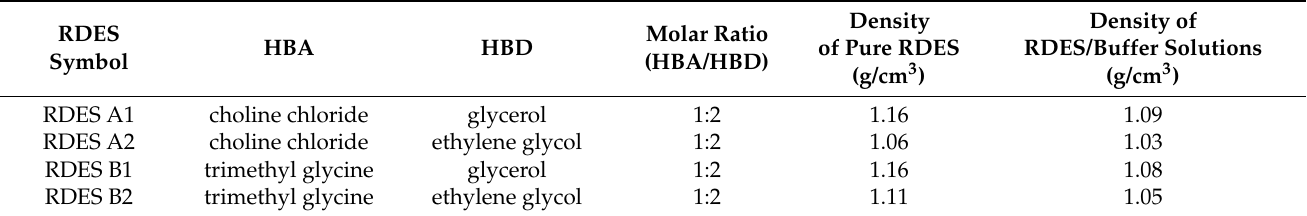
Table 2. List, composition, and density of RDESs (measured at 18 ◦ C) and reaction mixtures (RDES/buffer 1/1) which have been prepared and used in this study.